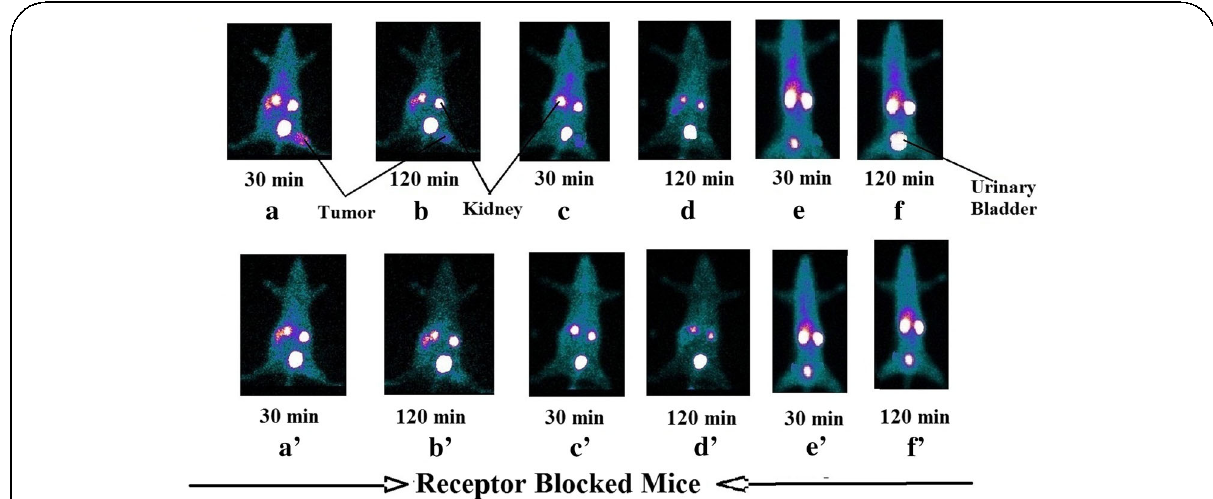
Fig. 12 Planar static images of MDA-MB-231 tumor-bearing mice at different time period after i.v. injection of ( a ) 99m Tc-BN4 alone at 30 min, ( b ) 99m Tc-BN4 alone at 120 min, ( c ) 99m Tc-BN3 alone at 30 min, ( d ) 99m Tc-BN3 alone at 120 min, ( e ) 99m Tc-BNS alone at 30 min, and ( f ) 99m Tc-BNS alone at 120 min. ( a ′ ) 99m Tc-BN4 blocked by co-injection of BNS at 30 min. ( b ′ ) 99m Tc-BN4 blocked by co-injection of BNS at 120 min. ( c ′ ) 99m Tc- BN3 blocked by co-injection of BNS at 30 min. ( d ′ ) 99m Tc-BN3 blocked by co-injection of BNS at 120 min. ( e ′ ) 99m Tc-BNS blocked by co-injection of BNS at 30 min. ( f ′ ) 99m Tc-BNS blocked by co-injection of BNS at 120 min. Three animals were used for each